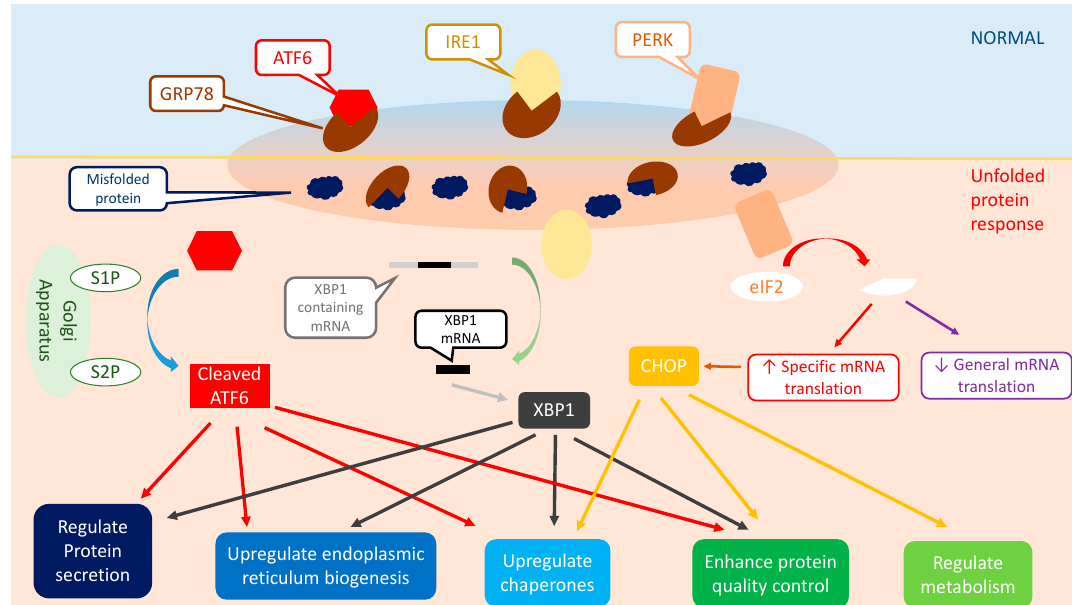
Figure 3. The UPR downstream signaling pathway. The UPR signal transducers, PERK, IRE1, and ATF6, are bounded by GRP78 under the normal condition. The accumulation of misfolded proteins triggers GRP78 to release and activate the UPR signal transducers to bind to the misfolded proteins, hence activating the UPR downstream signaling pathways. In the IRE1 pathway, IRE1 cleaves and releases XBP1 mRNA, which is translated to the active XBP1 protein that enhances the expression of UPR target genes. Meanwhile, PERK phosphorylates eIF2 and inhibits general mRNA translation, while upregulating the gene expression of resident ER proteins, hence reducing the ER workload to relieve the ERS. On the other hand, ATF6 migrates to the Golgi apparatus and is cleaved by the S1P and S2P protein, to expose its bZIP domain. Activated ATF6 is translocated to the nucleus and acts as a transcription factor to enhance the gene expressions of several ER resident proteins that contribute to protein folding, secretion, modification, and ERAD processes. * bZIP, Basic Leucine Zipper; eIF2, Eukaryotic Initiation Factor 2; ERAD, ER-associated Degradation; S1P, Sphingosine-1-Phosphate; S2P, Sphingosine-2-Phosphate.